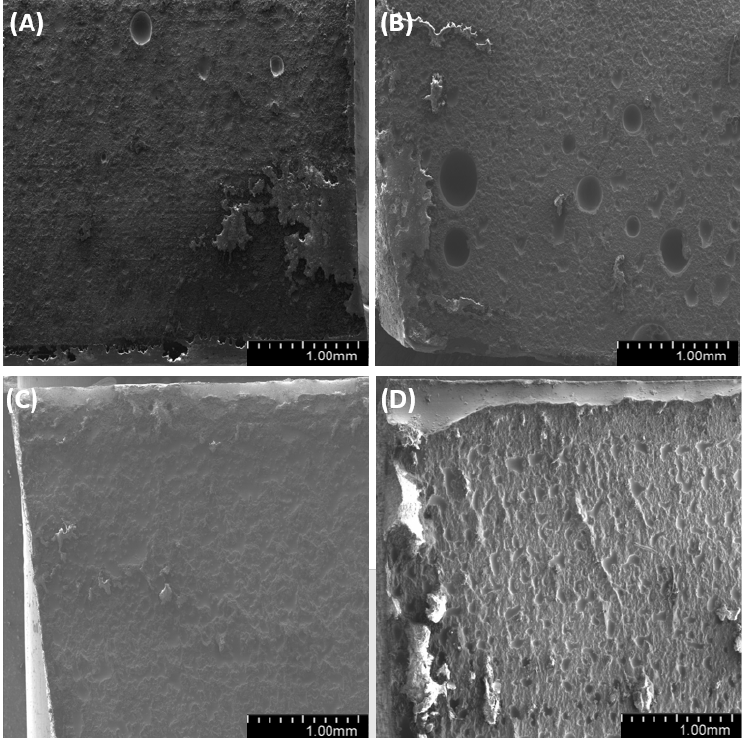
Figure 25. SEM images of mold wall with 36% vol. of diatoms: ( A )—base deg, ( B )—base no deg, ( C )—fractionated deg, ( D )—fractionated no deg.